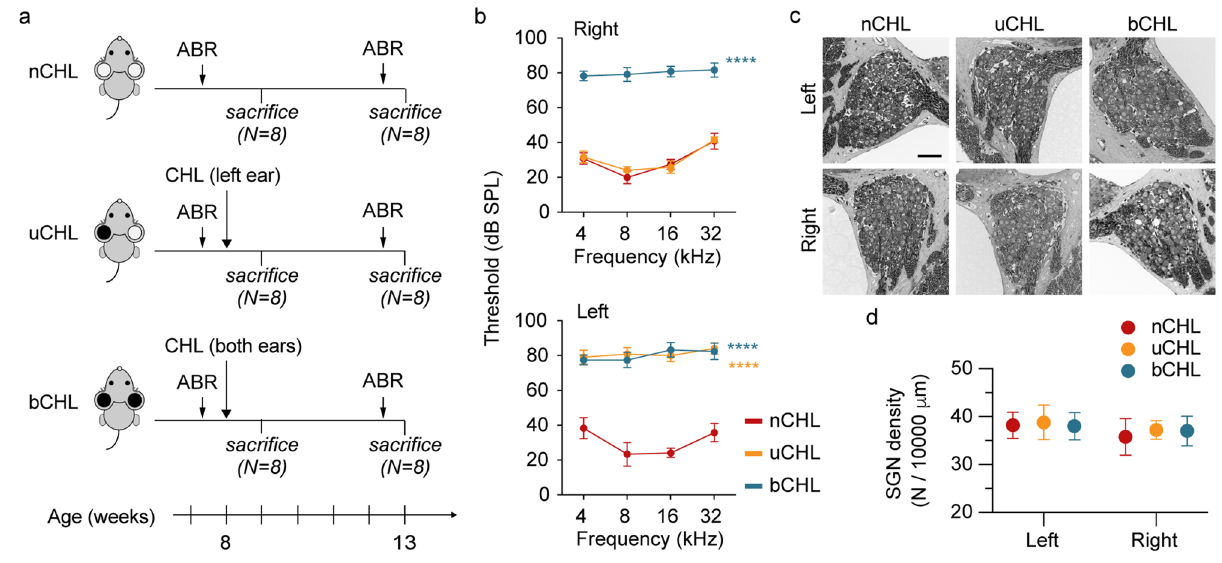
Figure 1. Experimental schedule and effects of ear occlusion on hearing thresholds and SGN survival. ( a ) Experimental schedule. ( b ) ABR thresholds at 5-weeks post occlusion (5 animals per group). Both ears